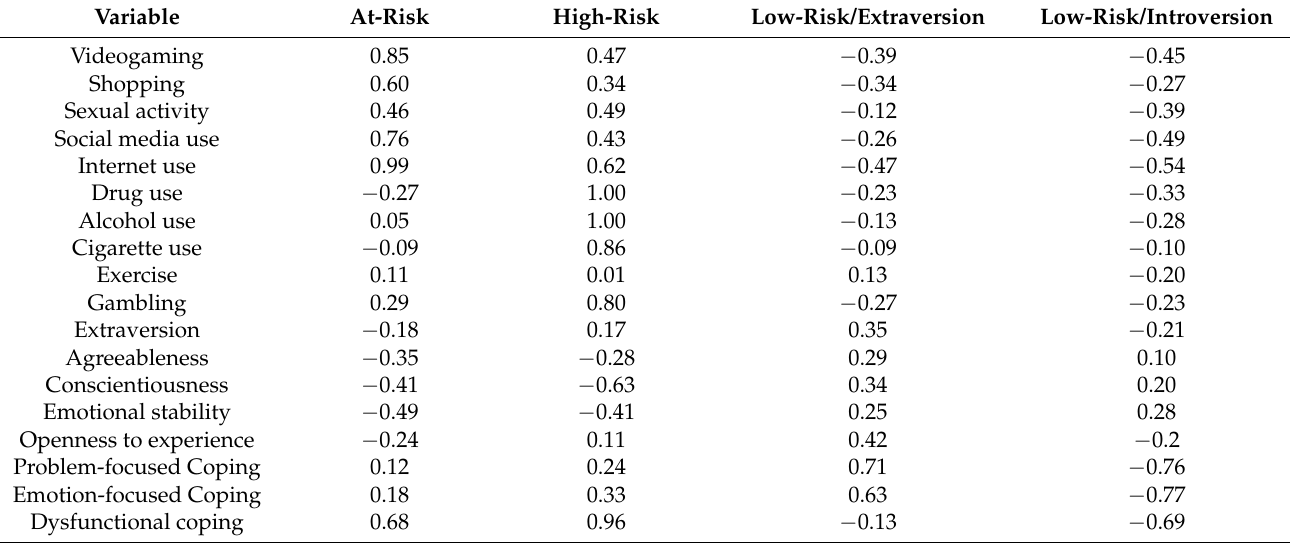
Table 5. Standardised score from the sample mean in the Australian